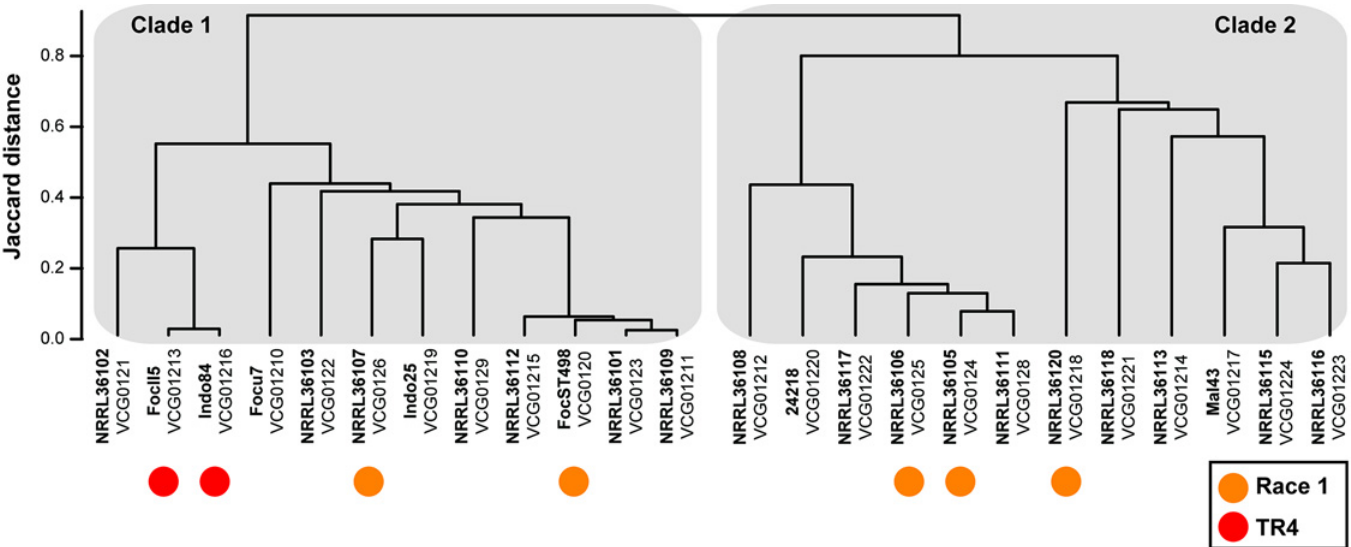
Fig 1. Genetic diversity of the banana pathogen F . oxysporum f. sp. cubense . Genotyping-by-sequencing analyses of the hitherto identified 24 vegetative compatibility groups (VCG) in F . oxysporum f. sp. cubense resulted in 12,978 DArTseq markers that divide Foc into two distinct clades — clade 1 and clade 2. VCG01216 is considered the same as VCG01213 [13]. The labels for race 1 isolates are based on personal communications with I. Buddenhagen and M. Dita. Although VCG01213 contains all TR4 isolates that cause the current Panama disease epidemic in Cavendish